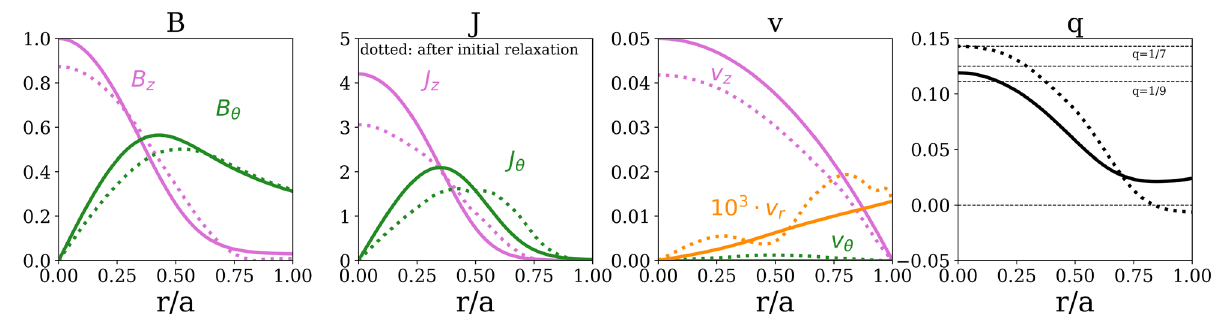
Figure 1. Radial profiles of the equilibrium magnetic, current density and velocity fields in the RFP cases. The B z component of the RFP magnetic field slightly reverses at the edge, giving the name to the configuration. Magnetic field is normalized to its on-axis initial value, velocity field is normalized to the corresponding Alfvèn velocity. Dotted lines represent the same quantities after the relaxation event following a slight perturbation of the initial equilibrium, resulting in the beginning of the 3D MHD dynamics. In this picture the modulus of all the quantities is plotted.